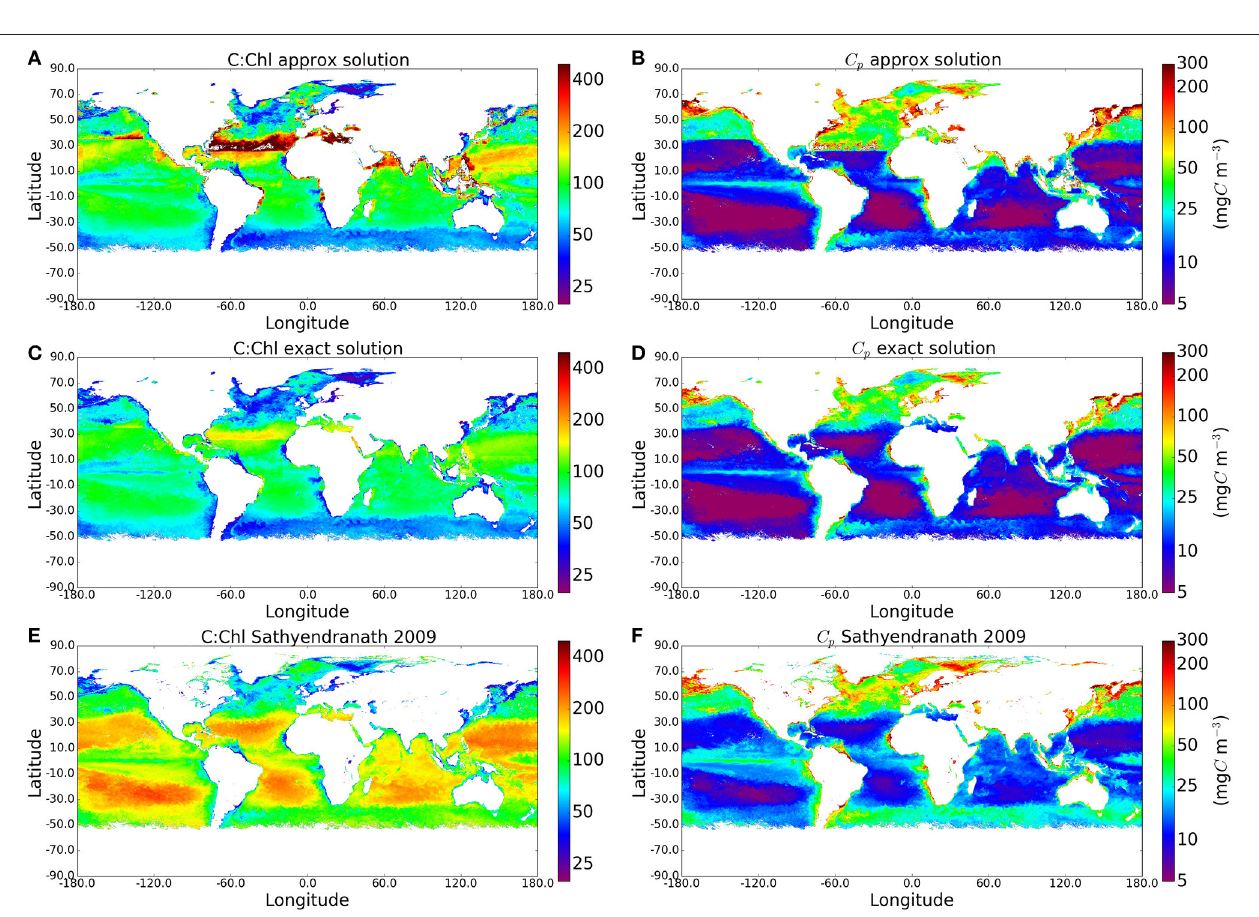
FIGURE 4 | Maps comparing the C:Chl and C p estimates using the original approxmiate solution, the new exact solution, and the method of Sathyendranath et al. (2009) globally for May 2010. The I * and Chl input fields can be seen in Figure 2 .